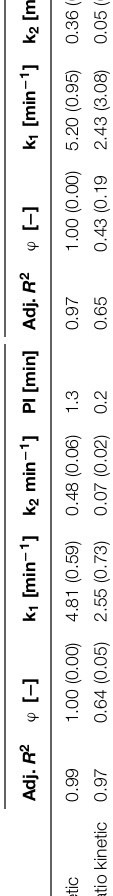
primary target of emitted (V)UV photons during the CAPP treatment. ROS, namely atomic oxygen and OH radicals, are well known for their oxidation potential and can react with almost all cell components (Surowsky et al., 2014). Whereas OH radicals have the highest oxidation potential of all ROS, they are able to oxidize unsaturated fatty acids, proteins and to initiate DNA damage (Laroussi, 2002; Surowsky et al., 2014). However, the saturation of B. subtilis endospores DNA with α / β -type small acid soluble proteins (SASP) protects the DNA against damage caused by OH radicals (Setlow and Setlow, 1993). Hence, the measured DNA damage can be attributed to the emitted (V)UV photons. The DNA damage ratio values showed the same dependence on the used feed gas composition like the maximum achieved inactivation. The fact that plasma running with pure argon obtained on both surfaces the highest DNA damage showed that VUV photons can play a significant role in the inactivation of endospores at atmospheric pressure. All DNA damage kinetics, except the one of argon + 0.135% vol. oxygen + 0.2% vol. nitrogen on glass beads, showed a continuous increase of DNA damage during the entire inactivation process. The DNA damage kinetic for the treatment on glass beads using plasma running with argon + 0.135% vol. oxygen + 0.2% vol. nitrogen merge into a tailing after 3 min ( Figure 4C ). However, the corresponding inactivation curve showed the same tailing, this behavior support the finding, that the damage of DNA due to (V)UV photons is one of the main inactivation mechanisms. The point of inflection between the two inactivation phases was achieved always significantly earlier for the DNA damage kinetics than for the corresponding inactivation kinetics ( Tables 3 and 4 ). The accelerated first inactivation phase is often attributed to the damage of DNA by (V)UV photons (Moisan et al., 2002), however, the different shift between the two phases for the inactivation and DNA damage showed that the (V)UV based inactivation is presumably not the only mechanism contributing to the first fast inactivation phase. The linear behavior for the DNA damage kinetic of argon + 0.135% vol. oxygen + 0.2% vol. nitrogen ( Figure 3C ) can be explained by the high amount of emitted ROS and RNS. High amounts of reactive species are necessary for the decomposition of endospores due to etching, which lead to exposure of former covered endospores in, e.g., agglomerates and consequently to a further DNA damage. The early shift in the inactivation kinetic at 0.4 min may indicate the point, where the inactivation based on UV photons change to an inactivation process based on UV photons and supported by etching and photodesorption. For both DNA damage kinetics of argon + 0.135% vol. oxygen (glass beads and glass petri-dishes) the shift between the two phases could not be calculated, because both ϕ were under 0.5 and the